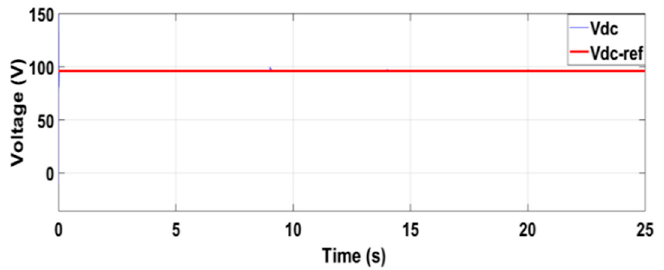
Figure 12. Motor torque and reference with EQZSI.